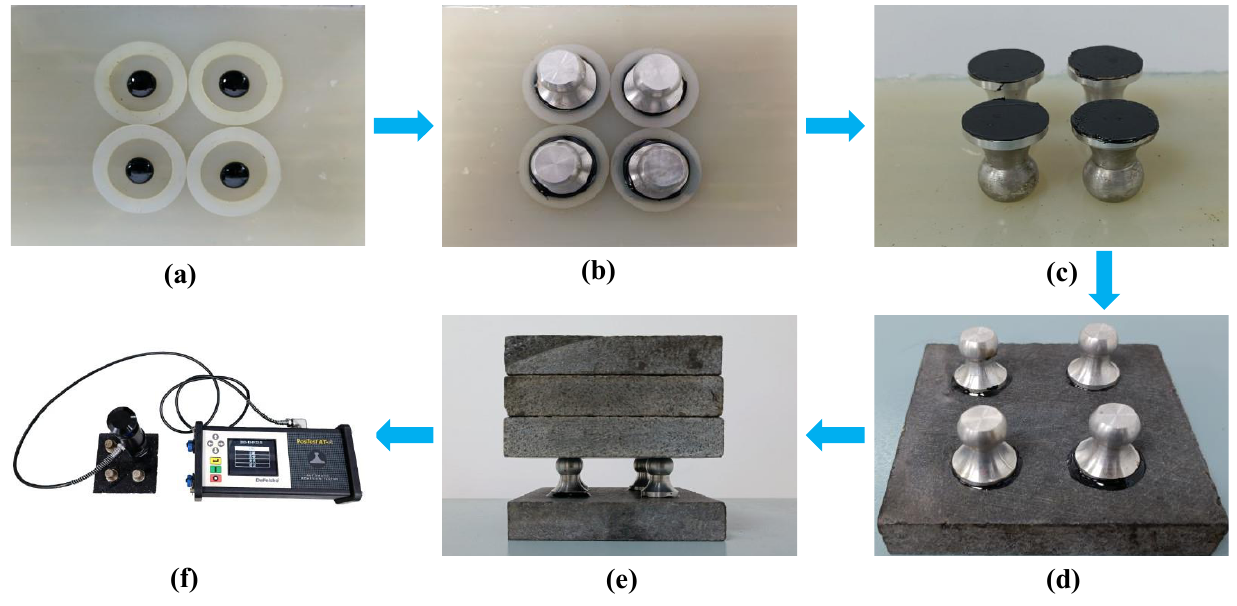
Figure 3. The BBS test method. ( a ) Pouring asphalt; ( b ) Sample preparation; ( c ) Attached sample ( d ) Sample on aggregate; ( e ) Loading sample ( f ) Detachment testing.